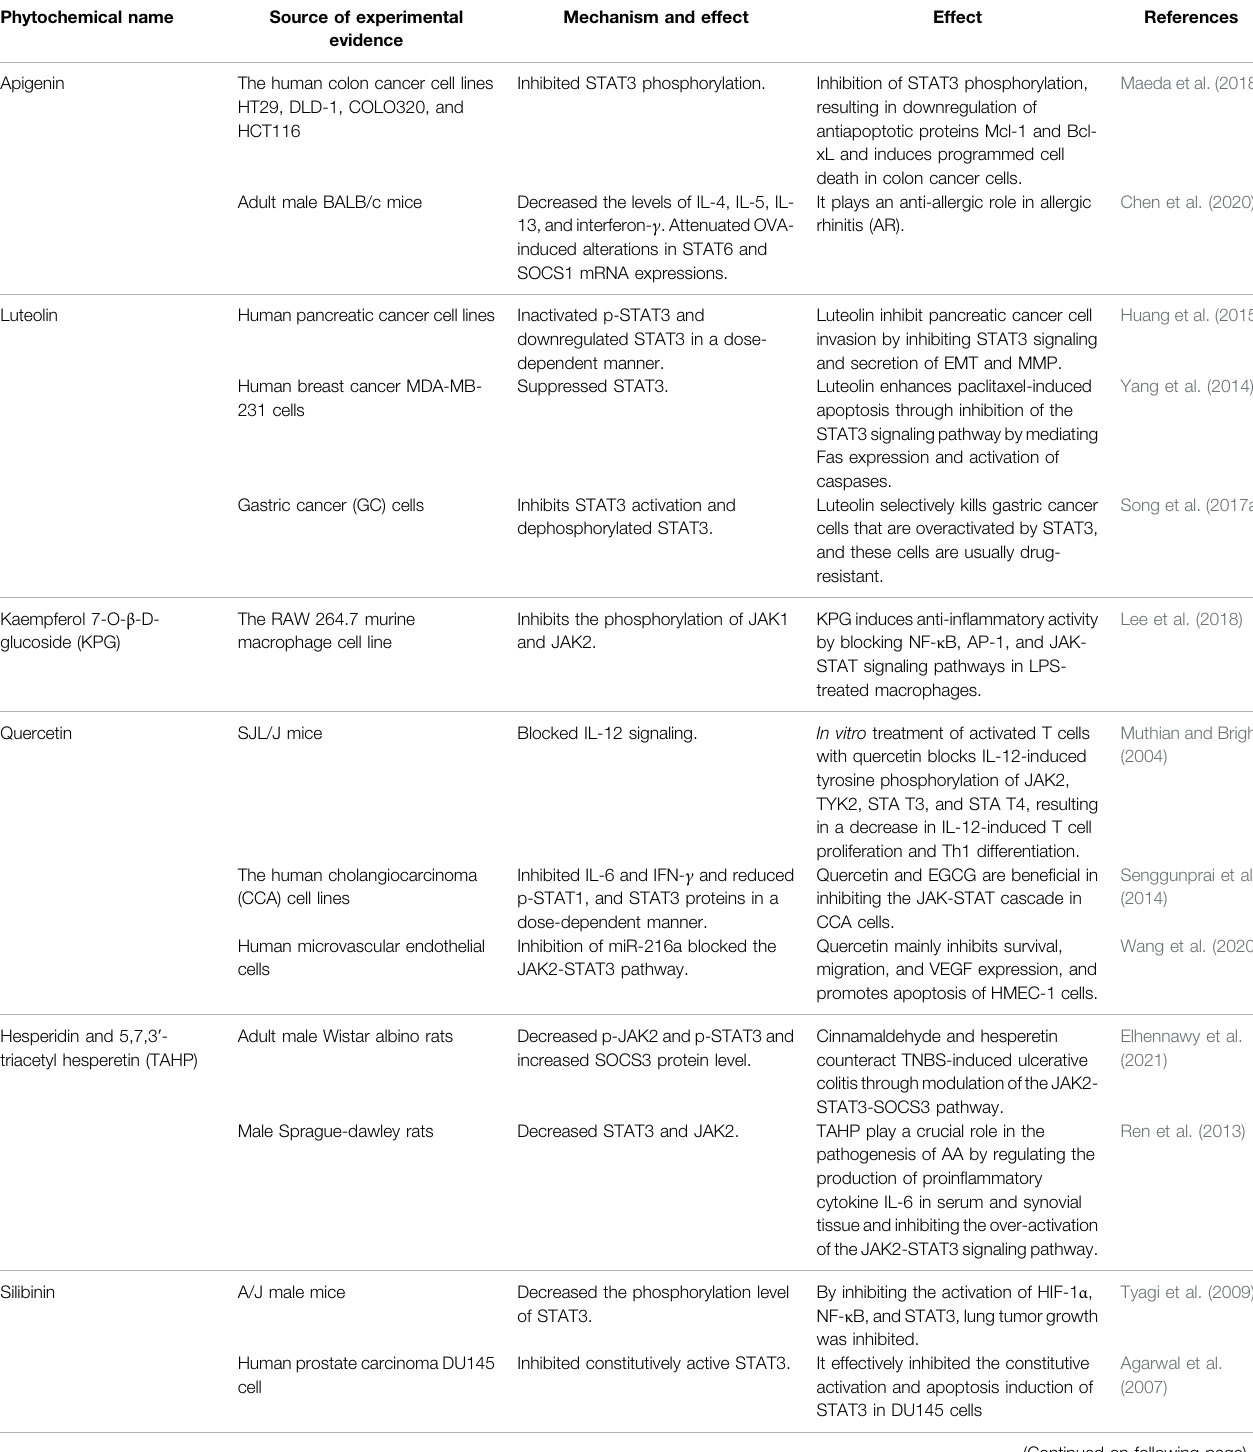
TABLE 2 | Pharmacological effects of polyphenol phytochemicals on the JAK-STAT signaling